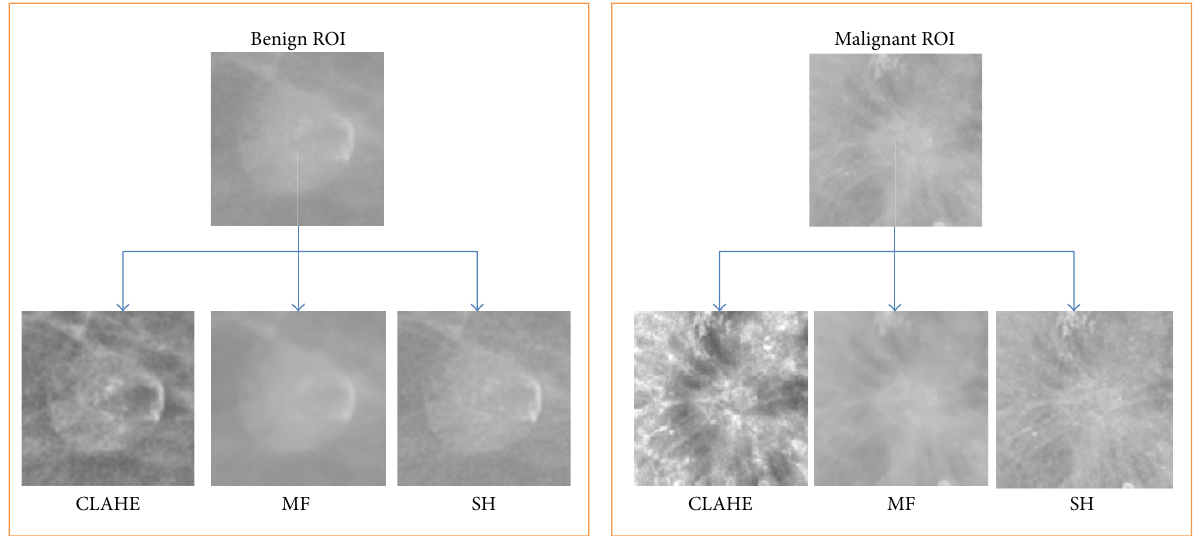
Figure 2: Examples of ROI